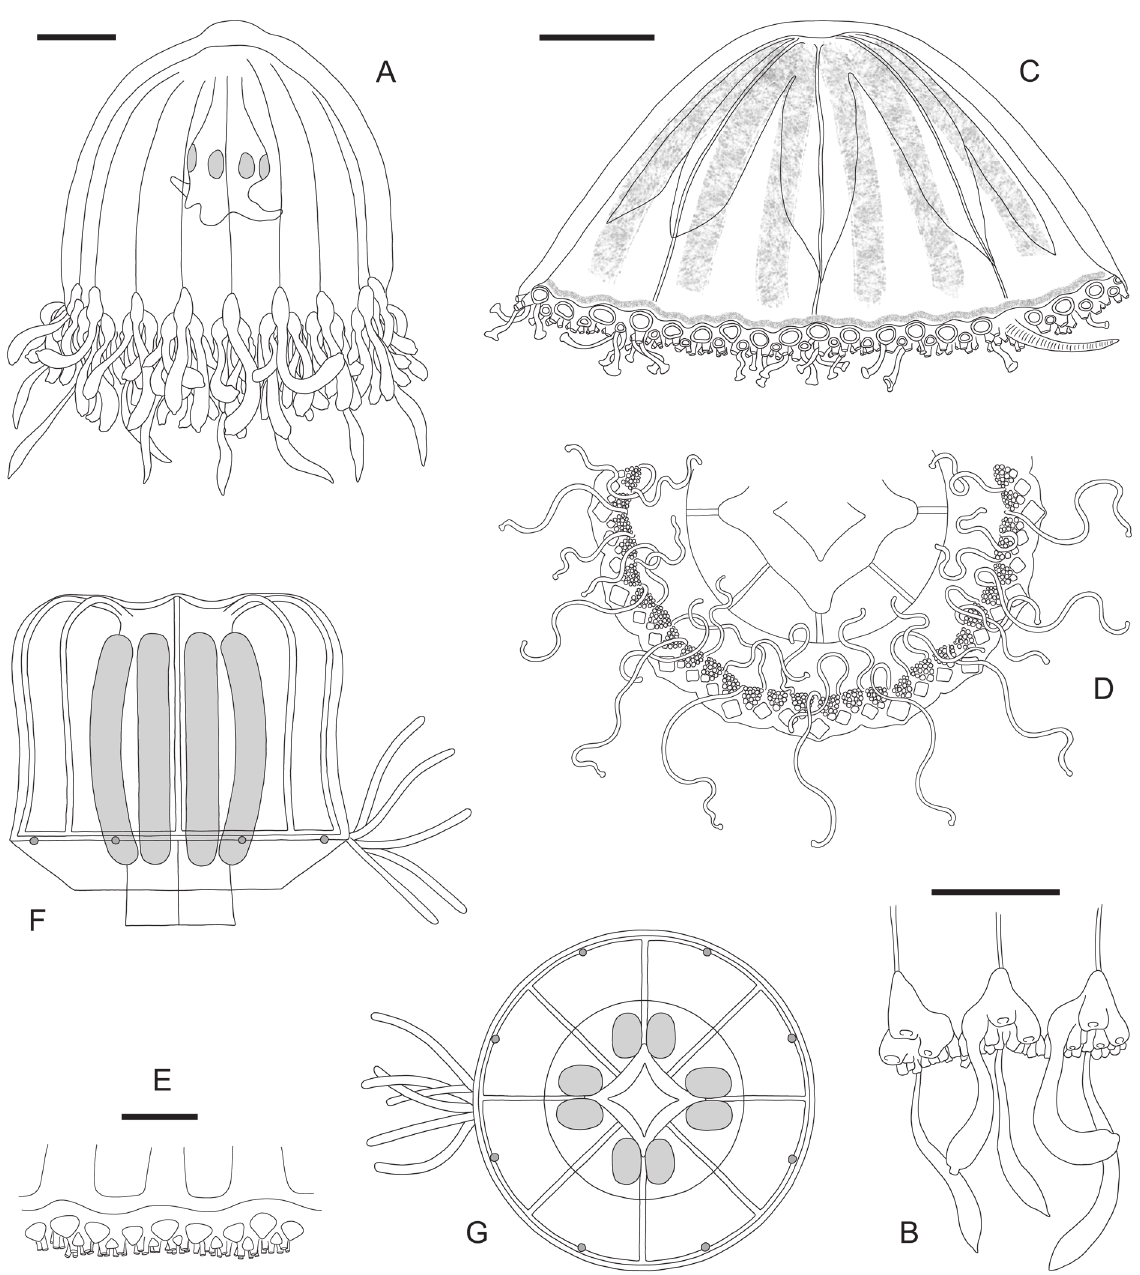
Fig. 4. — A – B . Ptychogastria asteroides (Haeckel, 1879). A . Lateral view of a medusa. B . Portion of umbrella margin showing the arrangement of tentacles. — C – E . Ptychogastria polaris Allman, 1878. C . Medusa in lateral view. D . Oral view of half of the medusa, showing the arrangement of the marginal tentacles. E . Portion of the bell margin, greatly enlarged. — F – G . Tesserogastria musculosa Beyer, 1959. Medusa in lateral (F) and oral (G) aspects. [A, B redrawn after Gili et al . (1999); C, E redrawn after Panteleeva et al . (1999); D redrawn after Haeckel (1881b); F, G redrawn after Hesthagen (1971)]. Scale bars: A, B = 500 µm; C = 3 mm; E = 2